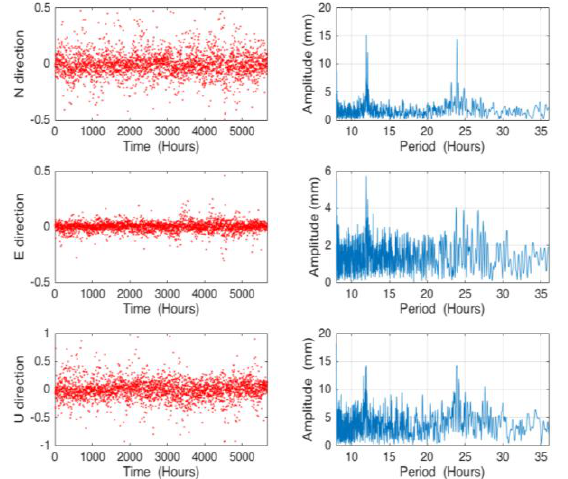
Figure 2. Coordinate time series (left) and spectrum analysis (right) of GDZH station